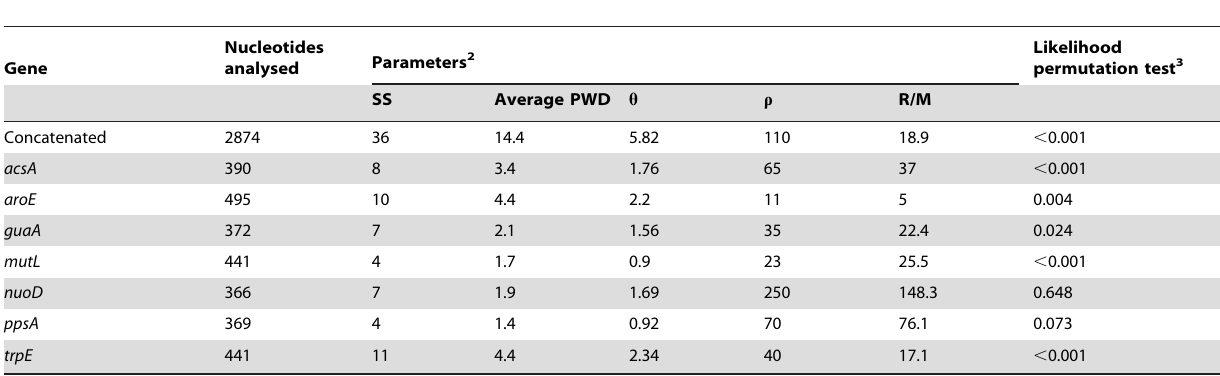
Table 5. Estimates of population-based mutation ( h ) and recombination ( r ) rates among the 272 Pseudomonas aeruginosa sequence types using LDhat.